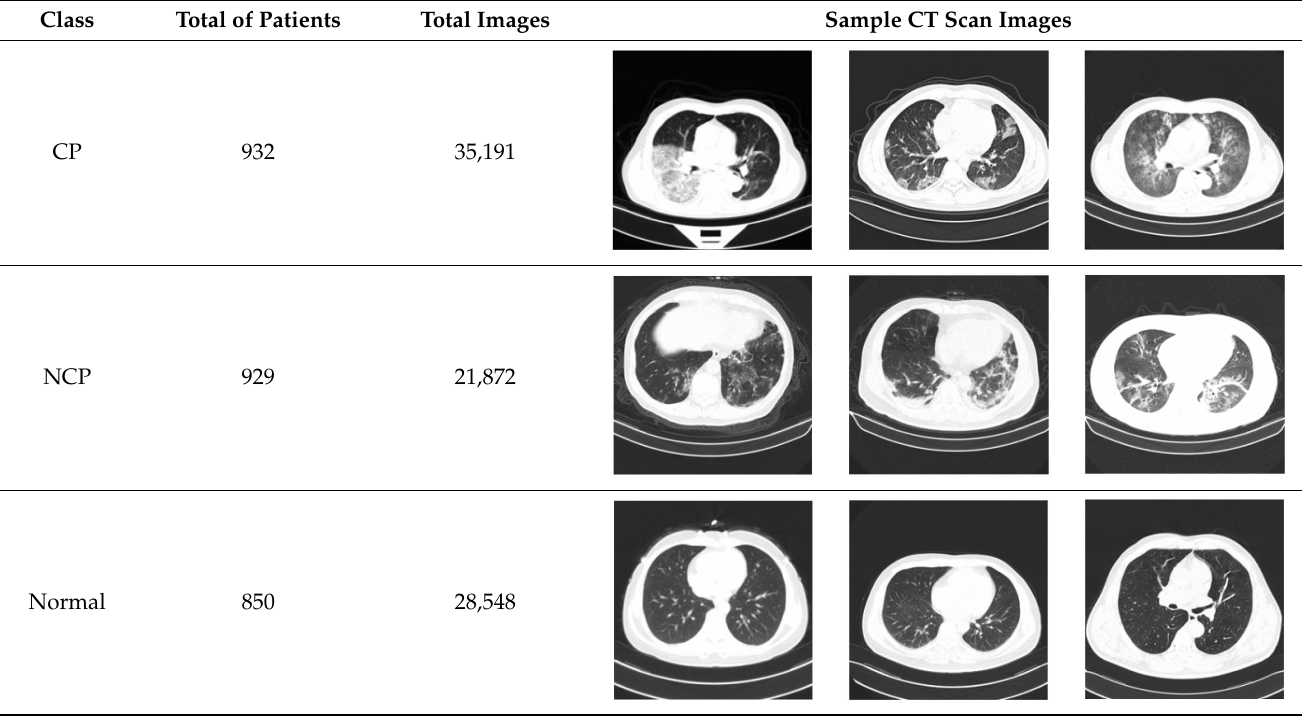
Table 1. Summary of the experimental dataset along with sample